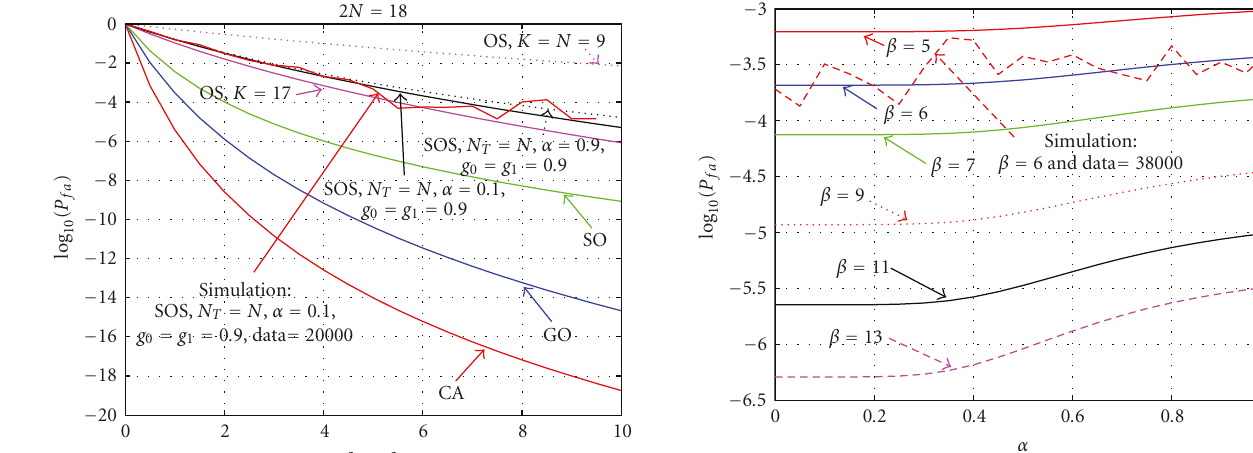
Figure 3: False alarm probability of the CA, GO, SO, OS ( k = N = 9 and k = 17), and SOS CFAR I processors for 2 N = 18.